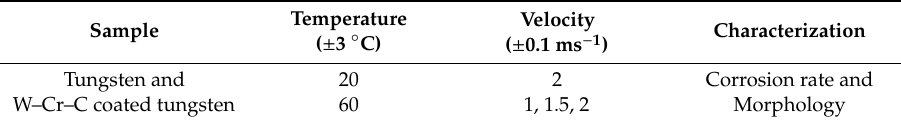
Table 2. The parameters set in the flowing water